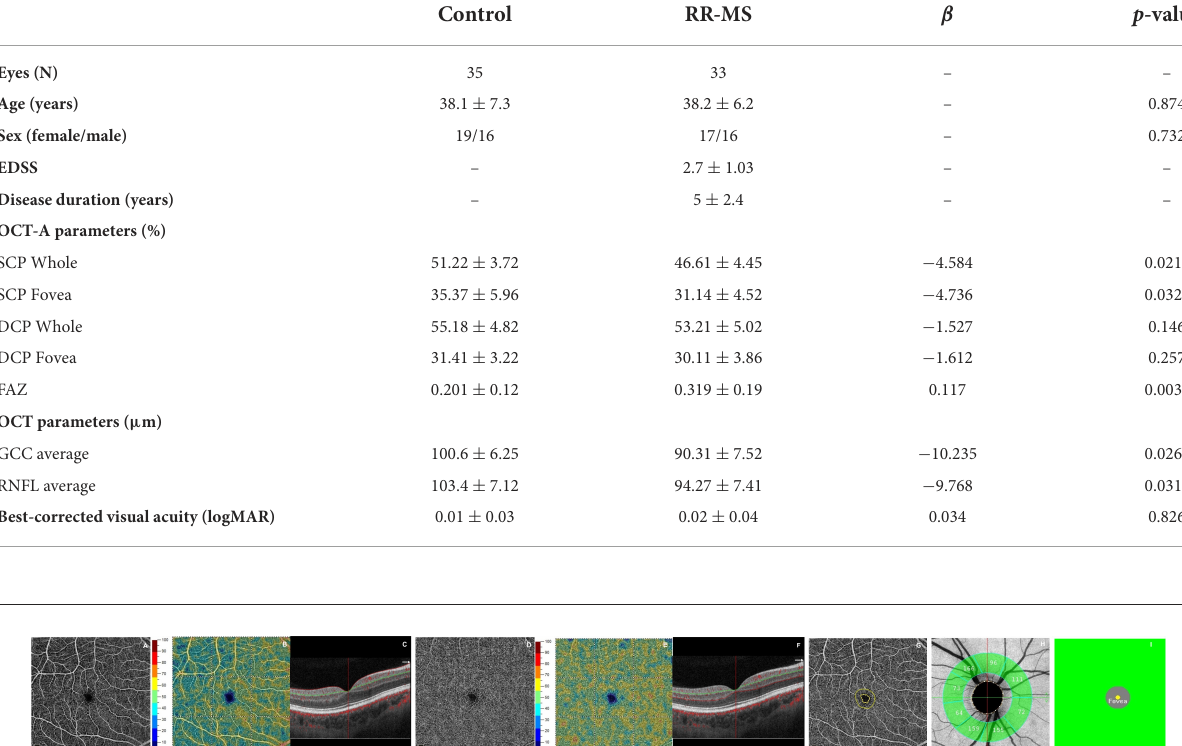
TABLE 1 Demographic, clinical features and differences in OCT/OCTA parameters between RRMS patients and healthy controls. Control RR-MS β